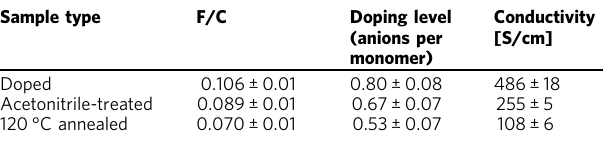
Table 2 Calculated atomic composition ratio of fl uorine to carbon (F/C) atoms, the corresponding doping levels, and conductivity values of doped, acetonitrile-treated de-doped, and 120 °C annealed de-doped fi